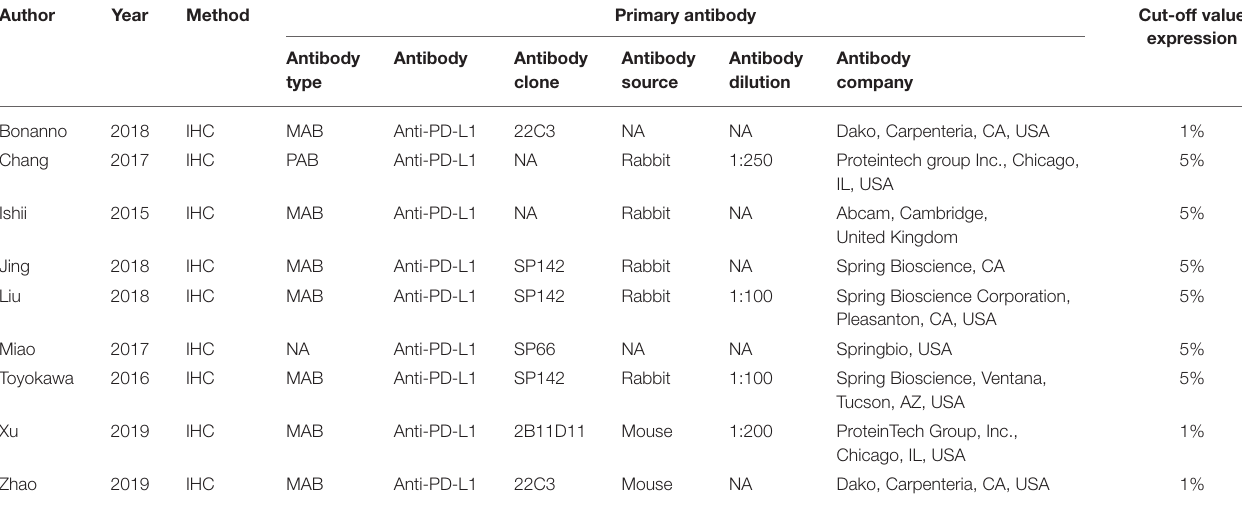
TABLE 2 | Methods for PD-L1 detection in this meta-analysis.